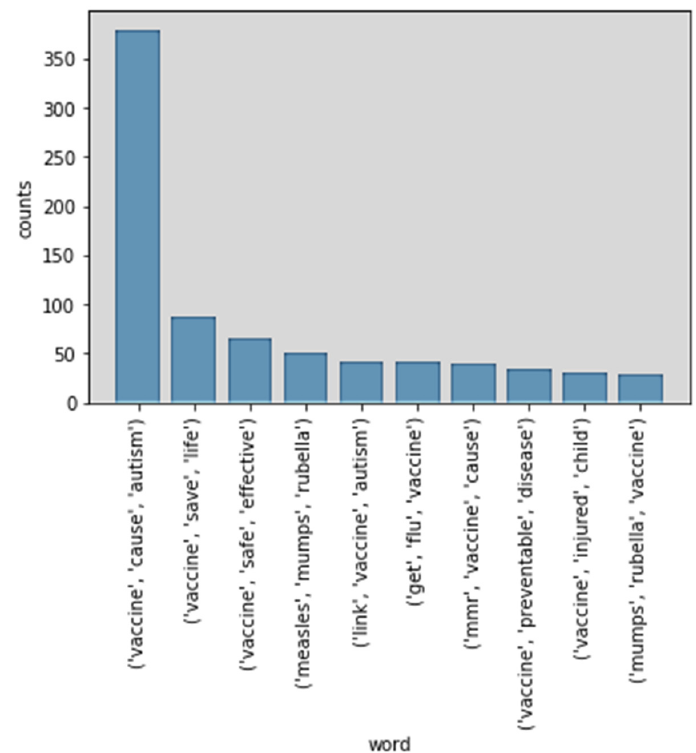
Figure 10. Top 10 trigram phrases.